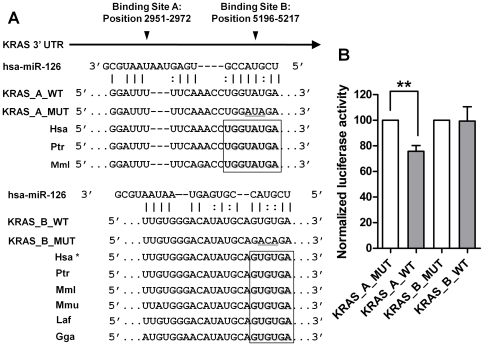
KRAS is experimentally validated as a direct target of miR-126 in pancreatic cancer cells.(A) Putative miR-126 binding sequences in the 3′-UTR of KRAS mRNA. Two different fragments from the 3′-UTR region of KRAS were cloned downstream of the luciferase reporters and named as wild-type (KRAS_A_WT and KRAS_B_WT). Two mutated versions of the miR-126 binding site were also generated (KRAS_A_MUT and KRAS_B_MUT); the mutated nucleotides of the miR-126 binding site are underlined. Boxed areas represent conserved complementary nucleotides of the miR-126 seed sequence in various species (Hsa, human; Ptr, chimpanzee; Mml, rhesus; Mmu, mouse; Laf, elephant; Gga, chicken). *indicates that KRAS_B_WT is conserved in 16 species. (B) Luciferase reporter assay. Each of the 4 plasmids (150 ng) and a Renilla luciferase reporter (50 ng) were co-transfected into MIA PaCa-2 cells with precursor miR-126 (100 nM). Luciferase activity was assayed 48 hours after transfection. All experiments were independently repeated at least three times; the results are presented as mean±SD (**P<0.01).